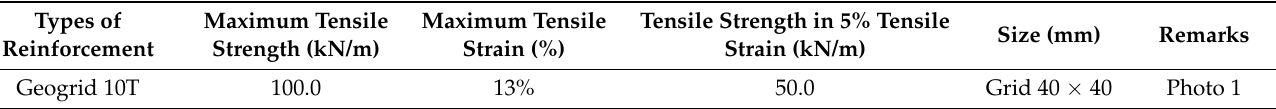
Table 1. Physical properties of reinforcement used for test.